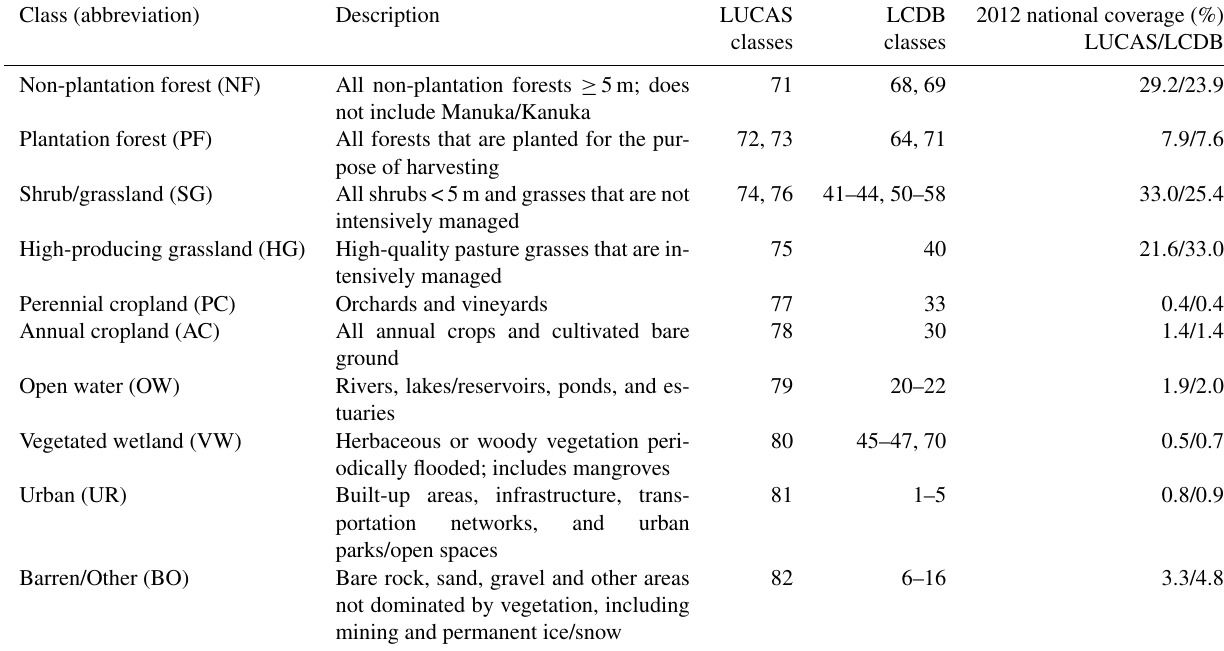
Table 3. Land use classification used in this study, aggregated from the LUCAS (v11) and LCDB (v4.1) land use/cover datasets. Class